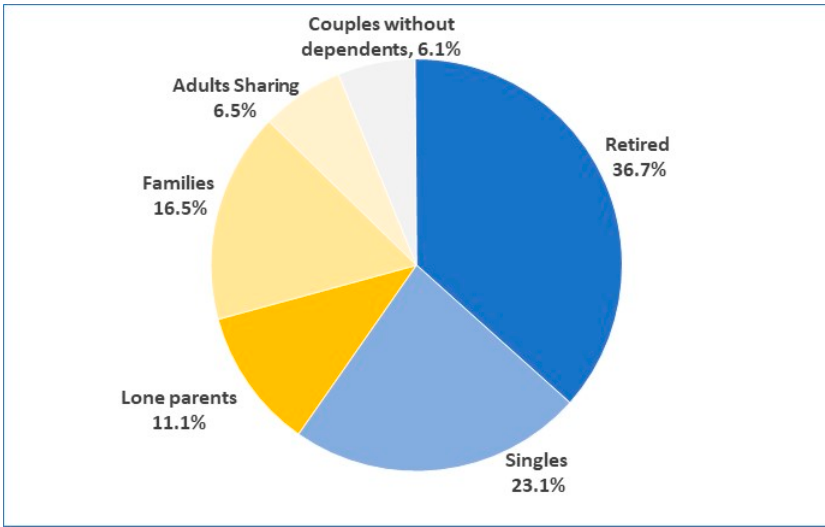
Figure 4. Proportions of different household types in the relative income poverty band. Energies 2020 , 13 , 5953